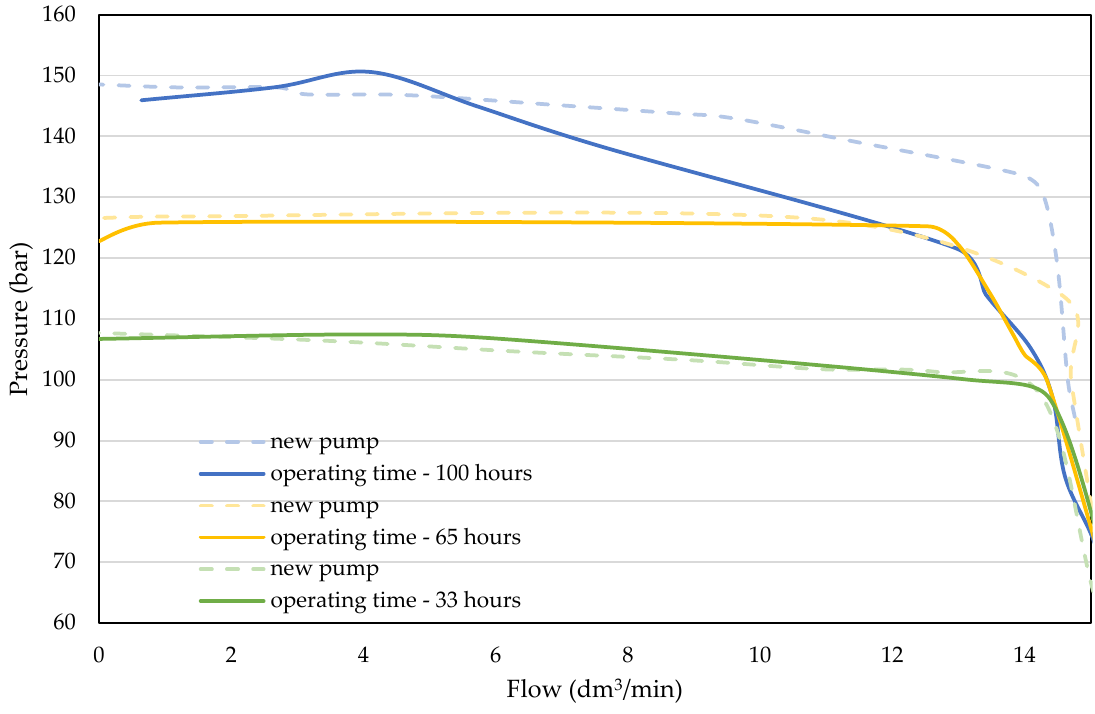
Figure 9. The hollow defect appeared after the last test stage ( a ) — ×100 magnification; ( b ) — ×300 magnification).